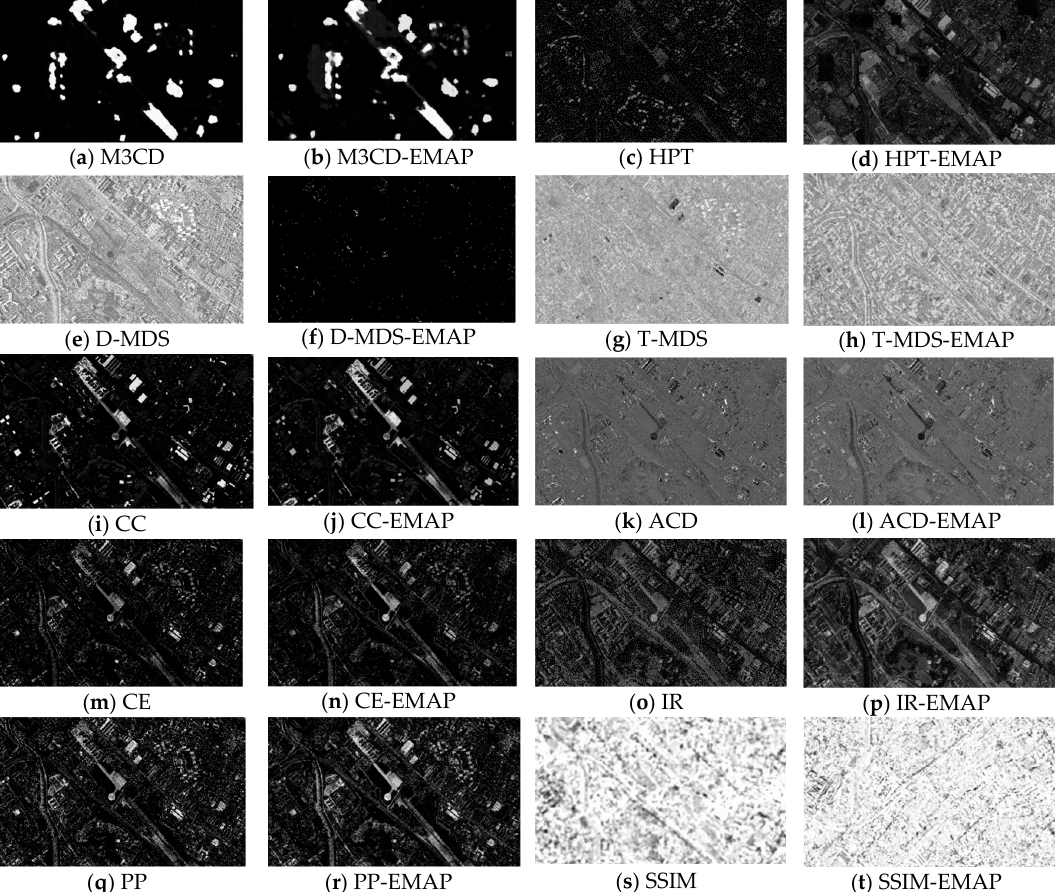
Figure 17. Ground truth and change detection score image for the best performing method (Image Pair-4).